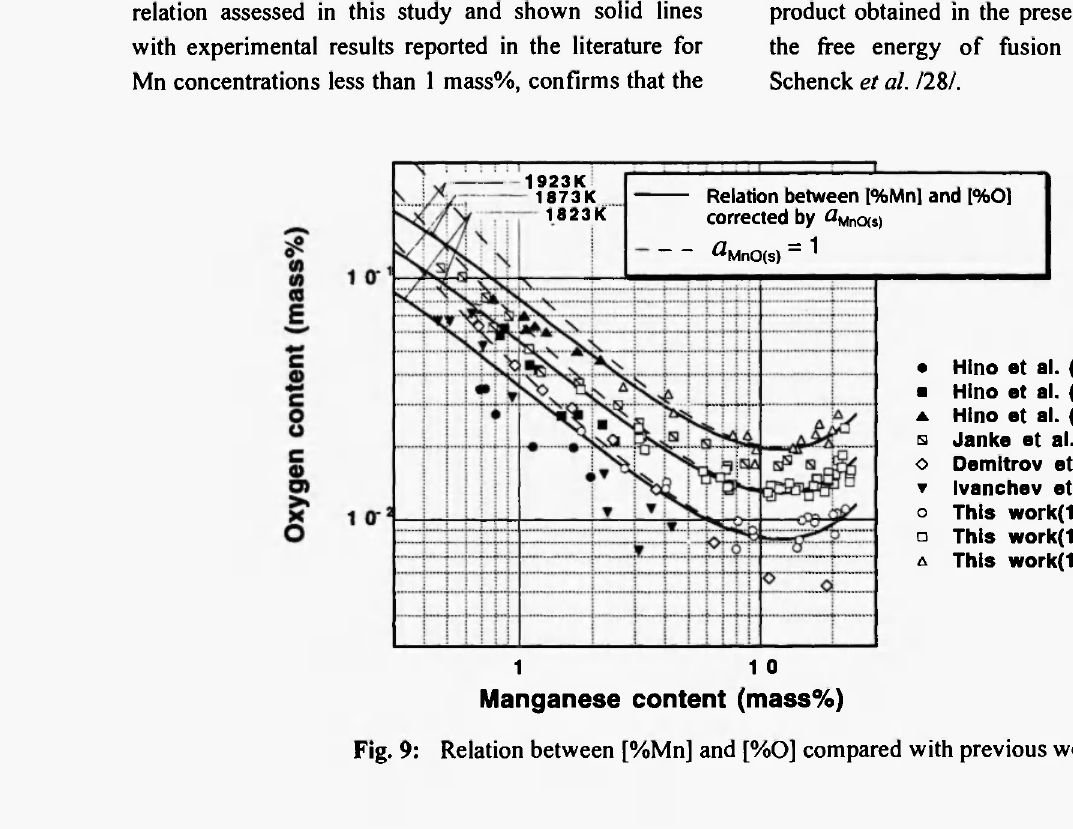
Fig. 9: Relation between [%Mn] and [%0] compared with previous